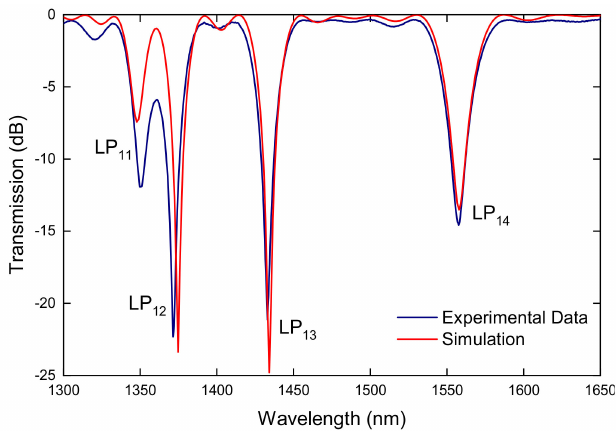
Figure 15. Transmission spectrum of an LPFG: experimental (solid line) and simulation (dashed line). Reprinted with permission from ref. [103]. © 2007 The Optical